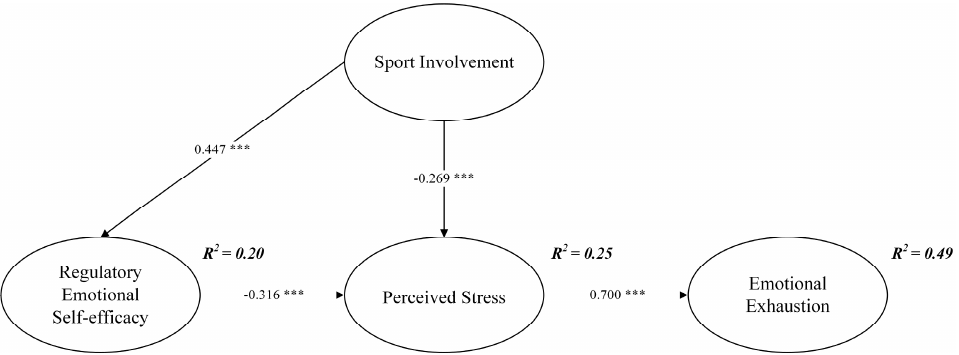
Figure 2. Structural path model. *** p < 0.001. Standardized coefficients are reported.